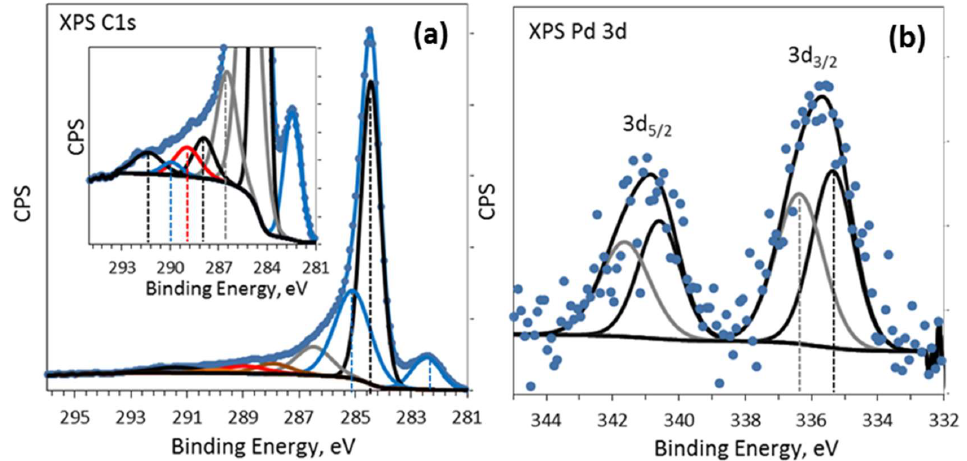
Figure 3. XPS C1s ( a ) and XPS Pd3d ( b ) spectra of Pd 1 /rGO 4 − TNR. The inset in ( a ) is a rescaled ( a ) to clearly show XPS C1s peaks with a relatively lower intensity.